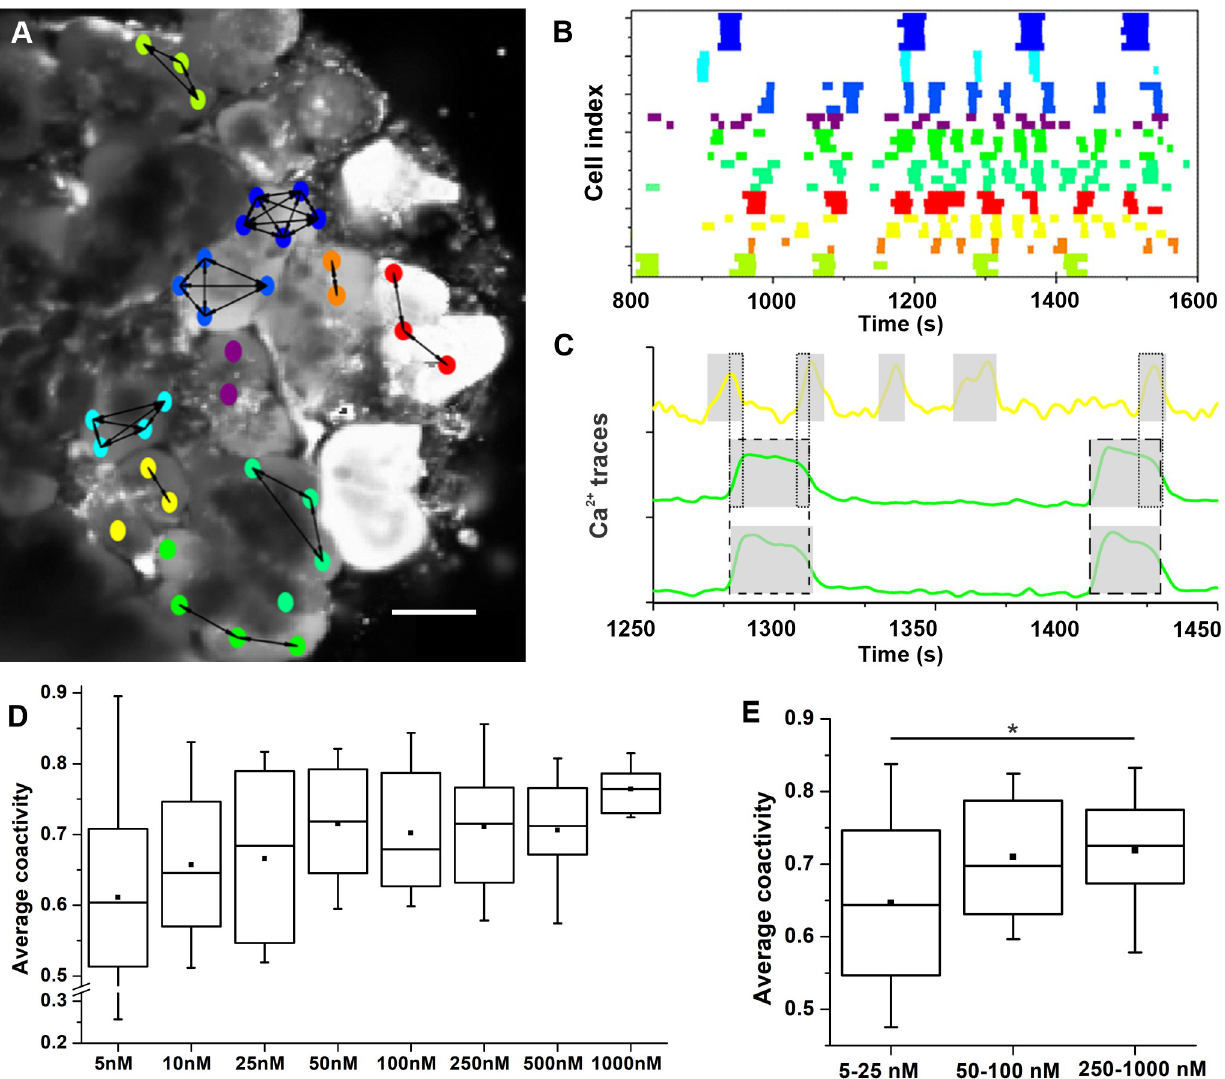
Fig 7. Inter-cellular synchronization of acinar cells. (A) Functional network of acinar cells extracted from coactivity and overlayed over a corresponding confocal image. Nodes denote individual acinar cells, colors code individual acini (matching the colors in panel B), and connections represent functional associations between synchronized cells, i.e., connections were established if the coactivity coefficient exceeded 0.65). Scale bar 10 μ m. (B) Raster plot of binarized activity of all acinar cells in the field of view of a tissue slice during stimulation with 50 nM ACh. White color indicates no activity, other colors represent states with elevated [Ca 2+ ] i in particular cells, whereby colors denote individual acini. (C) Visualized coactivity between three different cells, whereby two of them were located in the same acinus (green line) and the third cell belonged to a separate acinus (yellow). The grey shaded areas indicate the duration of [Ca 2+ ] i oscillations of individual cells and the dashed and dotted lines the degree of coactivity (i.e., overlap in activity) between the two cells displayed in green and the middle green and yellow cell, respectively. (D) Dose-dependent average coactivity between acinar cells within individual acini. (E) Pooled data for low (5–25 nM), medium (50–100 nM), and high (250–1000 nM) ACh concentrations. Boxes determinate the interval within the 25th and the 75th percentile, whiskers denote the minimal and the maximal values, lines within the boxes indicate the median and small squares stand for the average value. Significant difference is indicted by asterisk ( � , p <